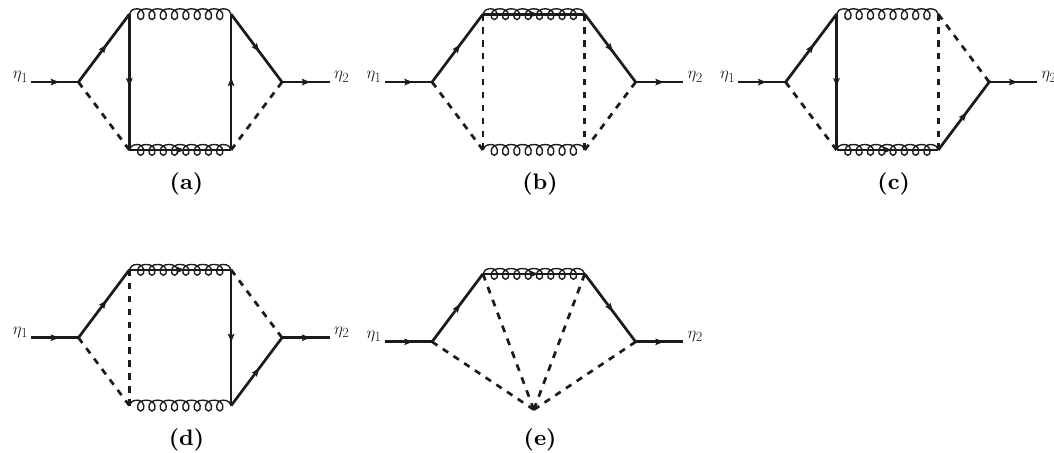
Figure 1. Typical three-loop Feynman diagrams contributing to the mass matrix element M 12 . The two sectors are connected via intermediate gauge boson and its supersymmetric